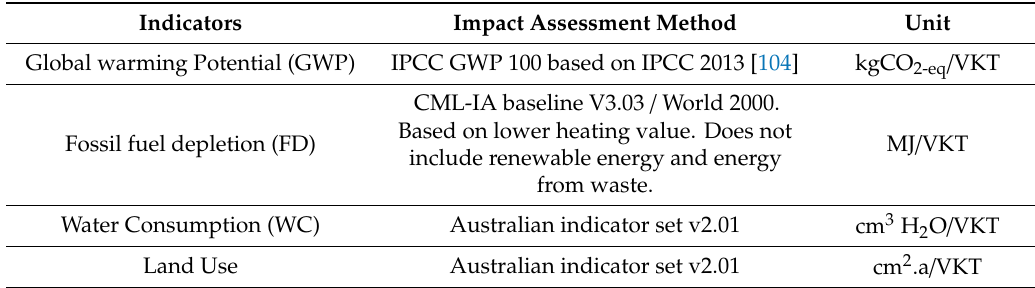
Table 9. Impact assessment methods to estimate the environmental